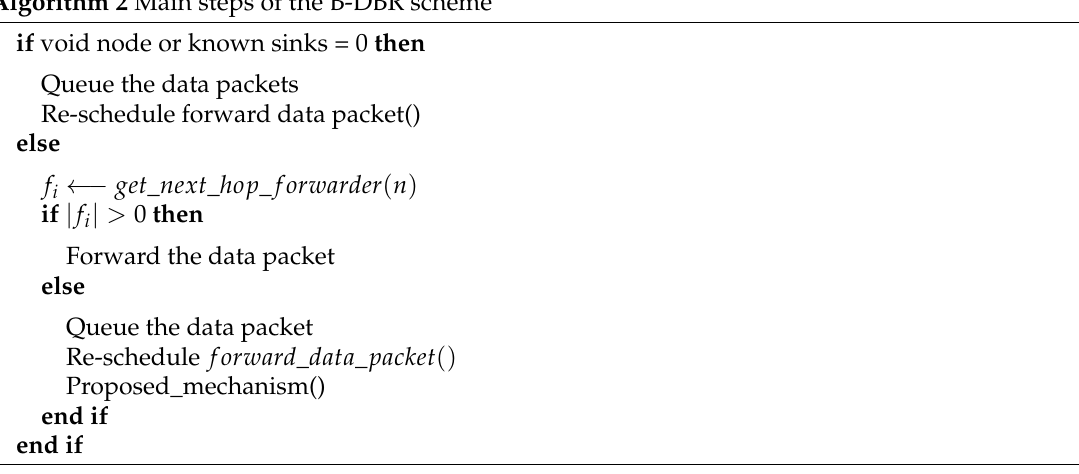
Algorithm 2 Main steps of the B-DBR